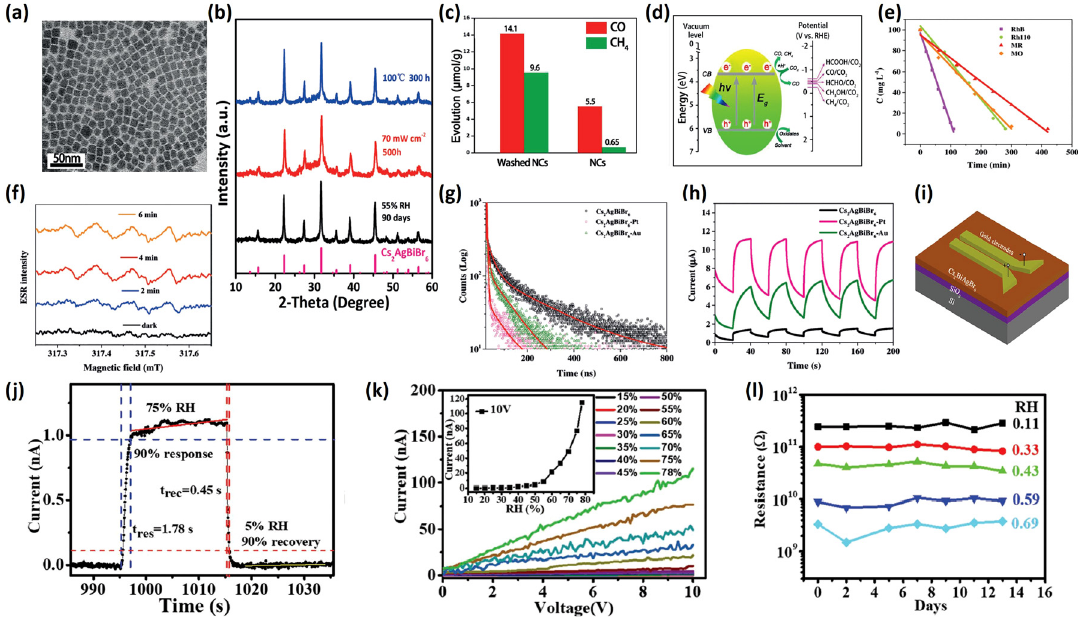
Figure 11: (a) TEM image of Cs 2 AgBiBr 6 QDs [212]. (b) XRD patterns of absolute ethanol washed Cs 2 AgBiBr 6 QDs stored in